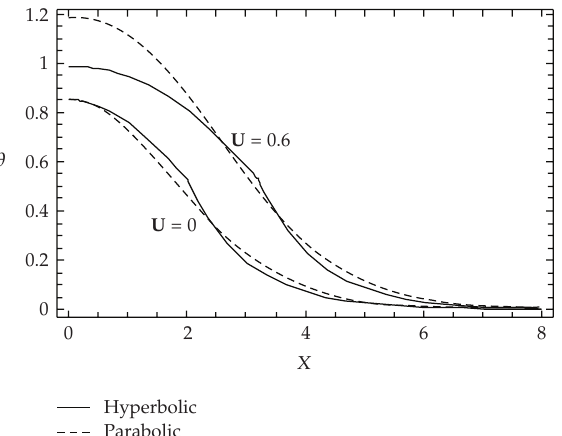
Figure 5: Dimensionless temperature distributions with dimensionless velocity of the medium for the instantaneous heat source; φ (cid:3) η (cid:4) (cid:5) δ (cid:3) η (cid:4) , ψ 0 (cid:5) 1 , β (cid:5) 1 , and η (cid:5) 2 .